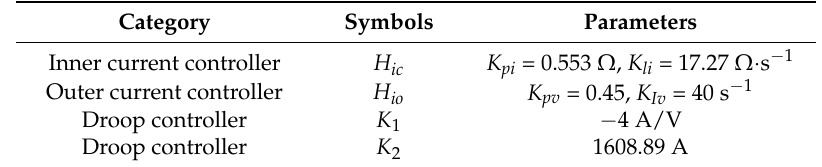
Table 1. Control Parameters.